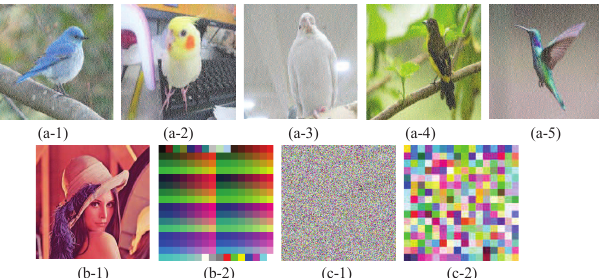
Figure 18. The proposed ( 5,5 ) -SDIS using 8 B 1 W block ( a ) five color meaningful shadows ( b ) 256-color SI and its corresponding CP ( c ) the recovered 256-color SI 1 and color palette CP (cid:48) under ( n − 1 ) -colluder